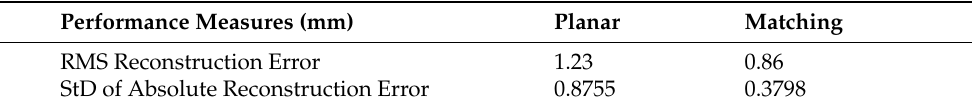
Table 11. 3D modeling errors of planar and matching